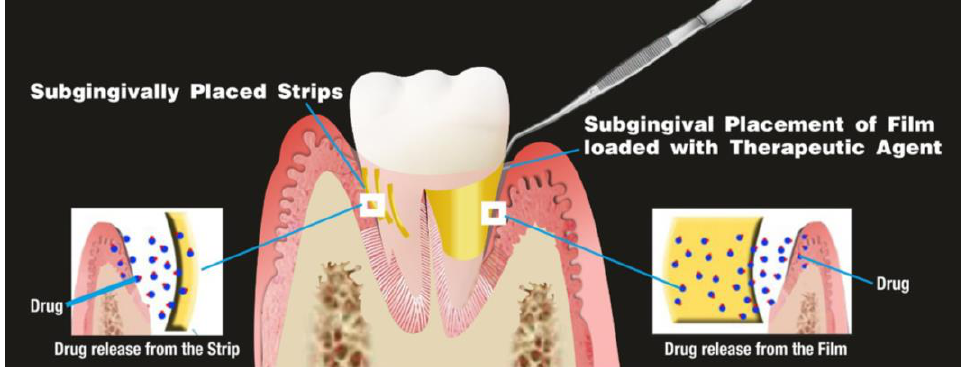
Figure 4. Strips and Films and their placement. Reproduced with the permission from Rajeshwari et al . ) [32].